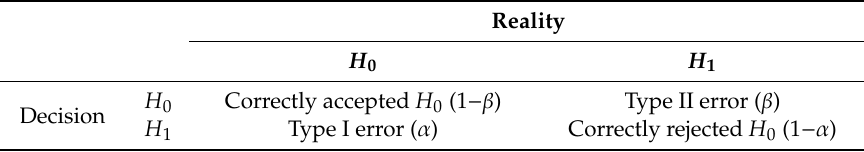
Table 2. Allowable decisions when testing statistical